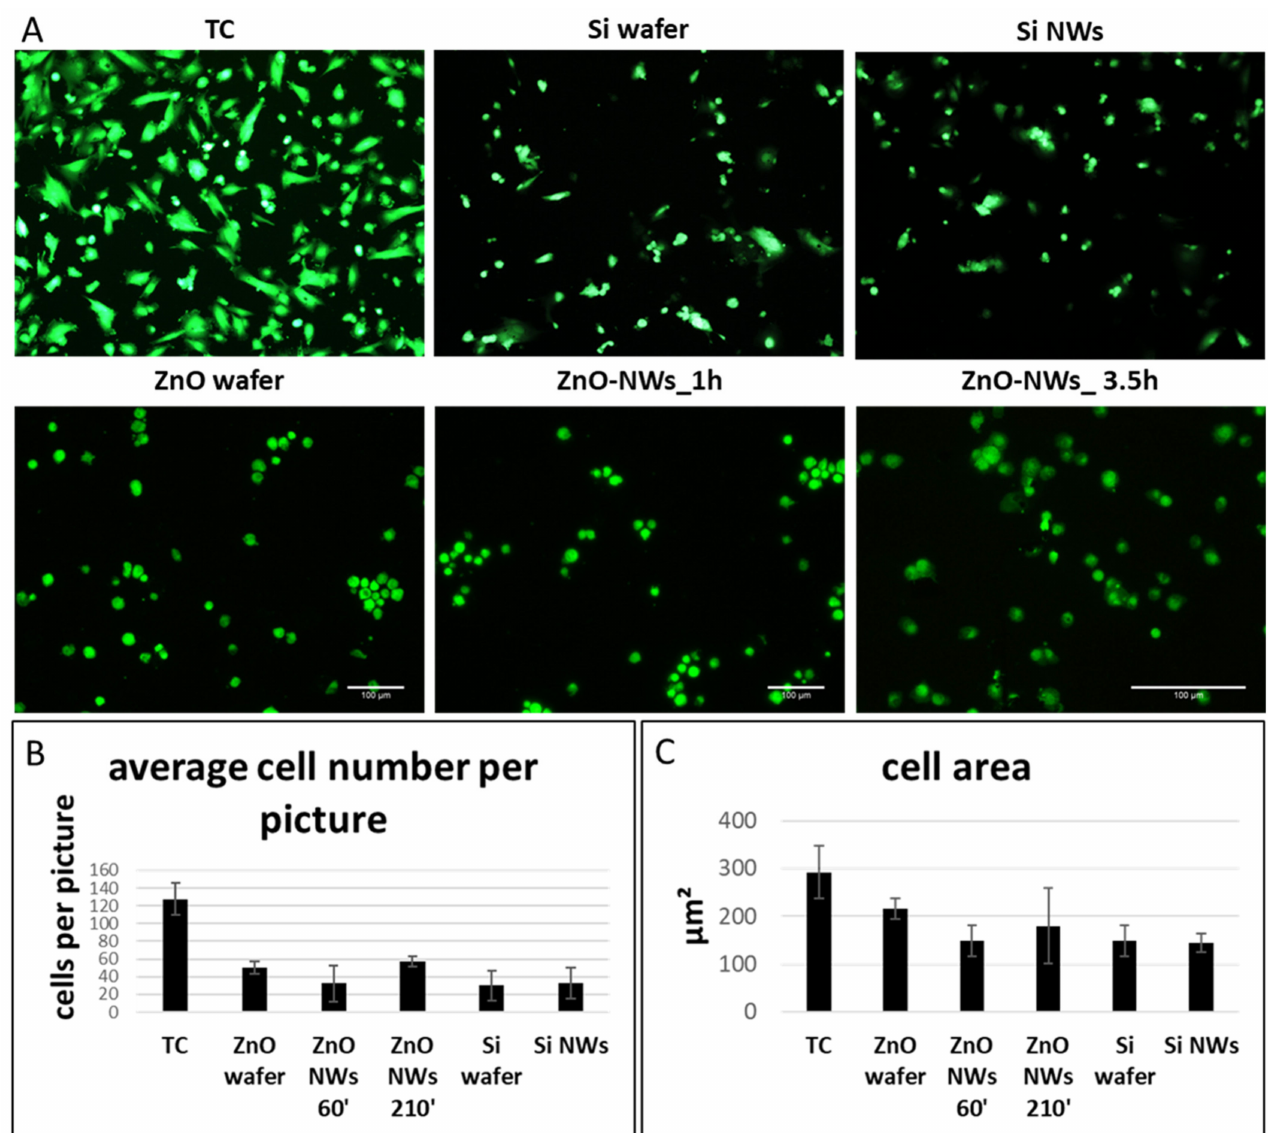
Figure 4. Viability assay of CSCs cultured on different Si- and ZnO-based substrates ( A ). Quantifica- tion of cell number per image ( B ) and their surface area ( C